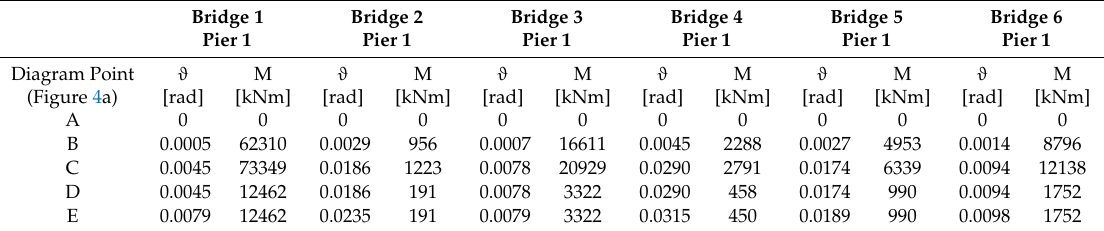
Table 1. Idealized moment-rotation plastic hinge relationships (Y-Y direction).